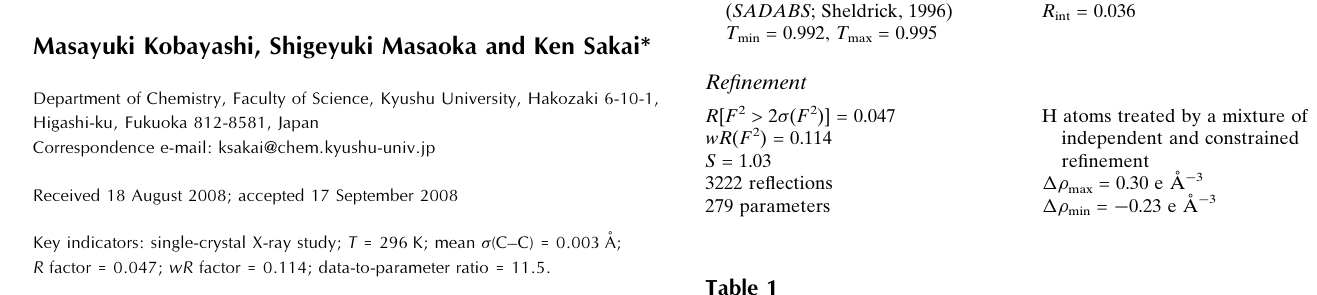
Hydrogen-bond geometry (A˚ , (cid:2)